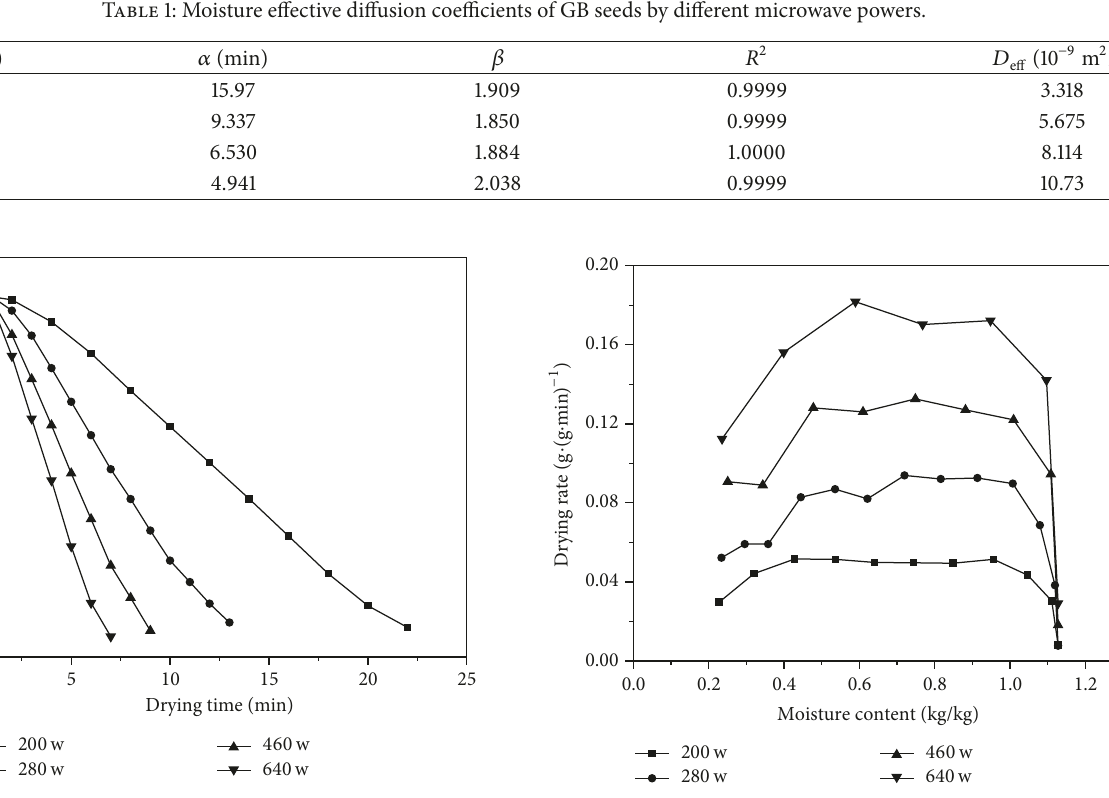
Figure 2: Drying kinetics of GB seeds under different microwave powers.